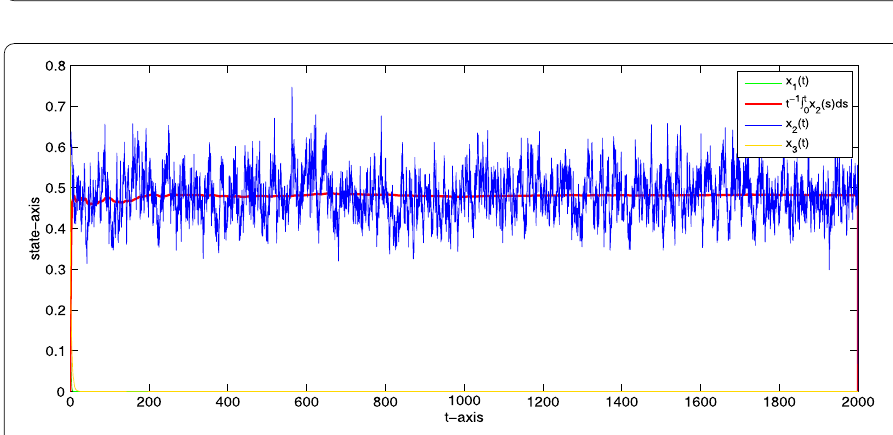
Figure 7 Both x 1 and x 3 die out while x 2 persists when γ 1 ( u ) = 2.5, γ 2 ( u ) = 1, γ 3 ( u ) = 3.5, and the other parameters are the same as those for Fig.